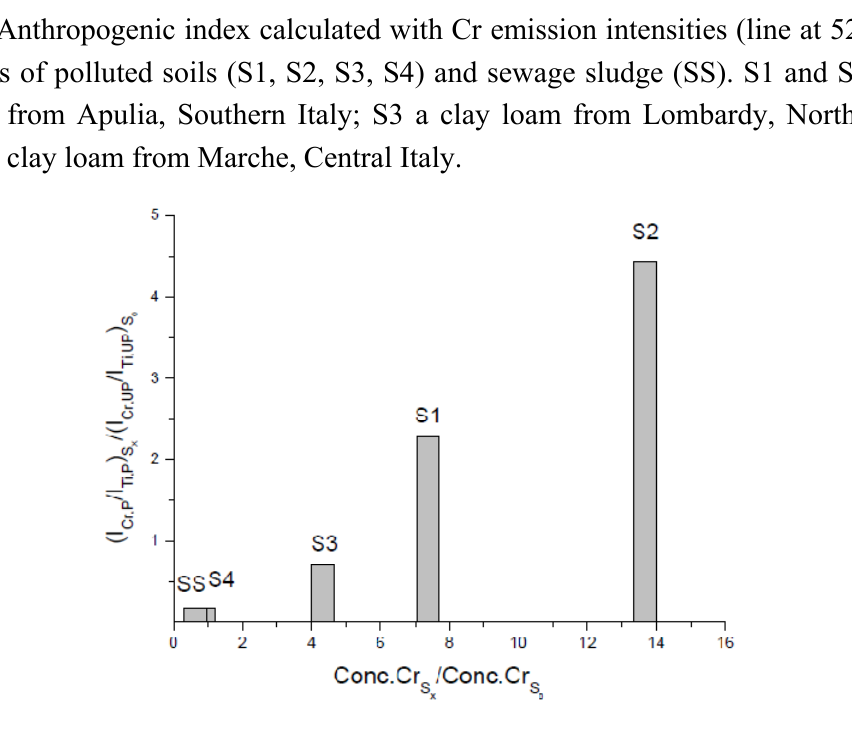
Figure 5. Anthropogenic index calculated with Cr emission intensities (line at 520.45 nm) for samples of polluted soils (S1, S2, S3, S4) and sewage sludge (SS). S1 and S2 are